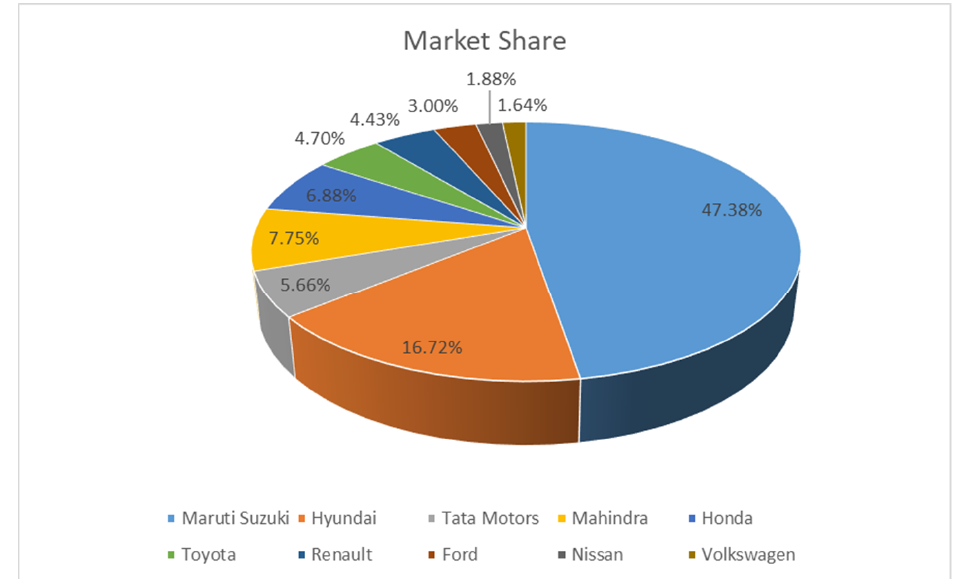
Figure 2. Main actors in India’s automotive clusters (passenger vehicle category). Source: Adapted from the Economic Times by Shah (2017).